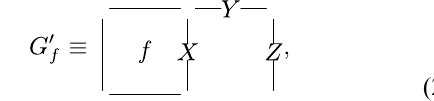
↔ XZ . Panel (c) represents the fermion green , which is mapped to the Pauli ZZZ f